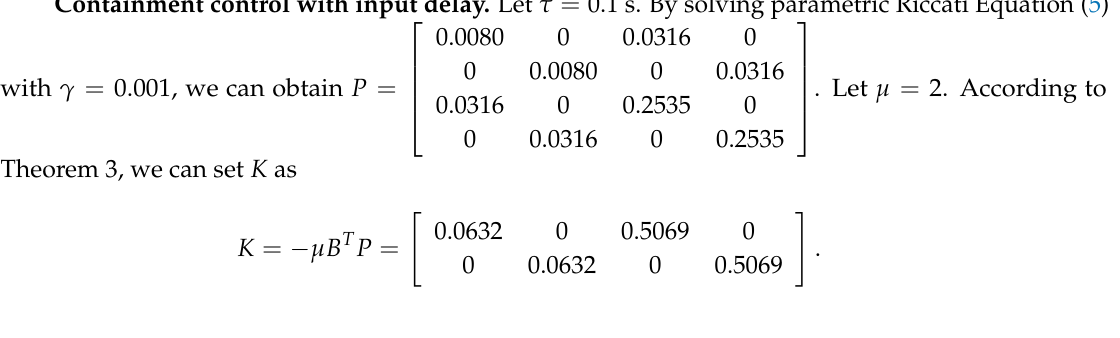
Table 1. Number of event instants of each edge ( τ = 0, 15 s).